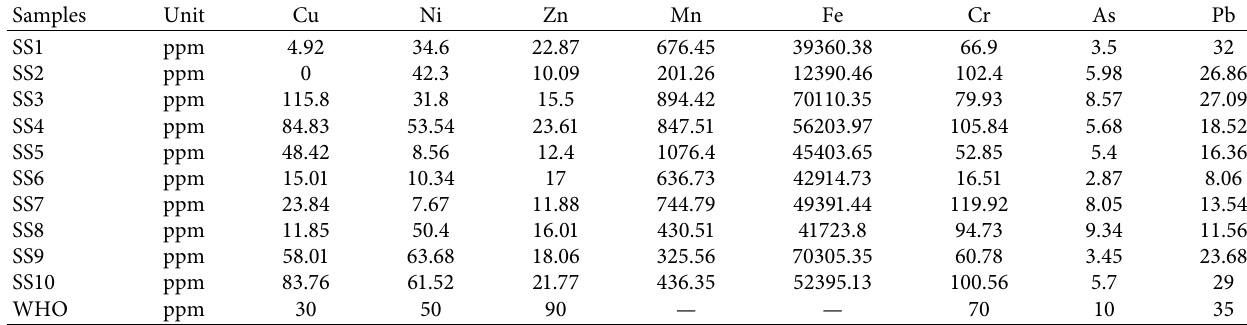
Table 3: Concentrations of heavy metals in sediment